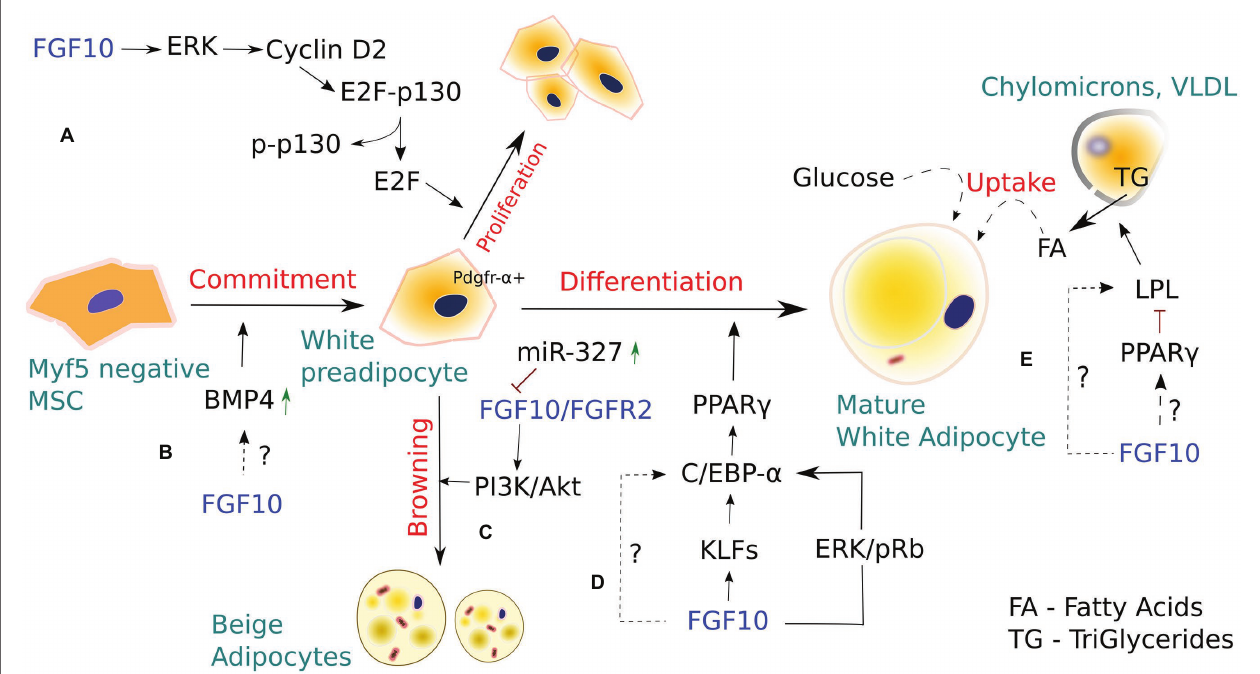
FIGURE 1 | The role of FGF10 in white and Beige adipocyte development. (A) FGF10-stimulated activation of the Ras/MAPK pathway induces proliferation of white preadipocytes via cyclin D2-dependent phosphorylation of p130. (B) Bone morphogenic protein 4 (BMP4), acting downstream of FGF10, is known to regulate FGF10-mediated bud outgrowth during branching morphogenesis of the developing lung, thus contributing to controlling bud size. In adipogenesis, BMP4 stimulates commitment of pluripotent stem cells toward the white adipocyte lineage. However, whether a dynamic interplay between FGF10 and BMP4 occurs in adipogenesis, similar to that seen in embryonic lung development, remains to be elucidated. (C) FGF10 is part of a miRNA-327-regulated autocrine loop that stimulates development of Beige adipocytes from Pdgfr α + white preadipocytes. However, Beige adipocytes are also thought to arise from mature white adipocytes via β -3 adrenergic stimulation, cold exposure, and chronic PPAR- γ induction. (D) FGF10, via a number of signaling routes, activates downstream PPAR- γ , which in turn induces white adipocyte differentiation. (E) FGF10 overexpression in intramuscular adipocytes enhanced the expression of lipoprotein lipase (LPL) and LPL- induced lipid accumulation, suggesting a possible role for FGF10 in regulating adipocyte metabolism. However, LPL is also known to be regulated by PPAR- γ , and thus whether FGF10 would target LPL directly or via PPAR- γ to exert its effects in adipocyte metabolism remains to be